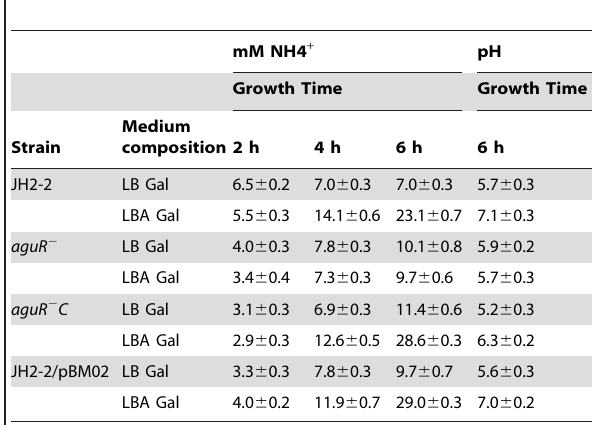
Table 2. Ammonium production and final pH values of E. faecalis strains grown in the presence or absence of